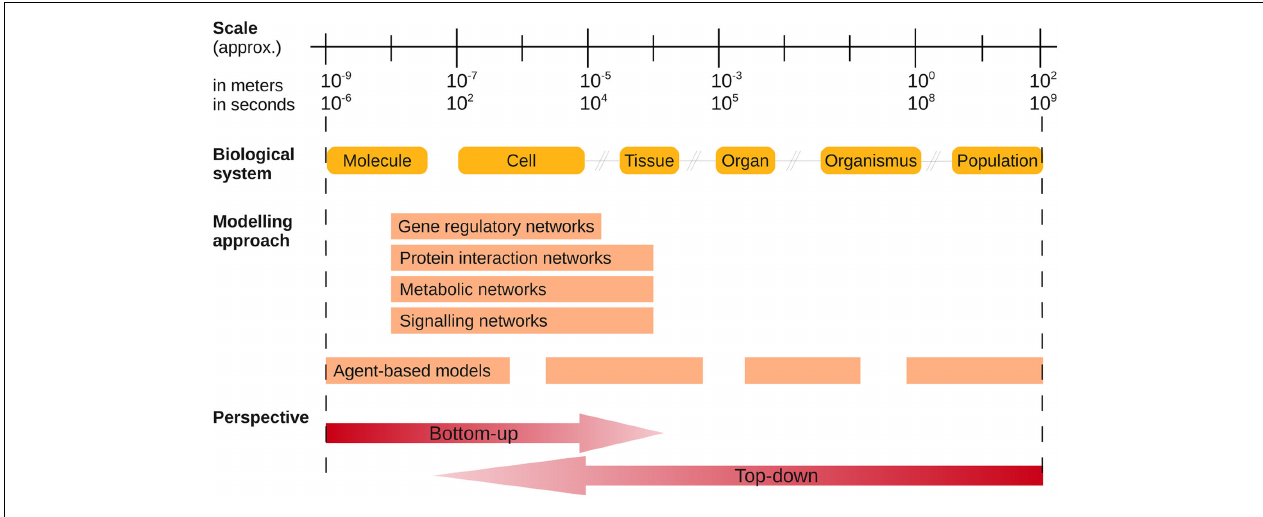
interplay.The flexibility and adaptability of agent-based modeling allows analysis at multiple levels without any restrictions with respect to the biological system. In order to generate new hypotheses, the advantages of bottom-up and top-down models are usually incorporated into the analysis. (Figure adapted from Forst,